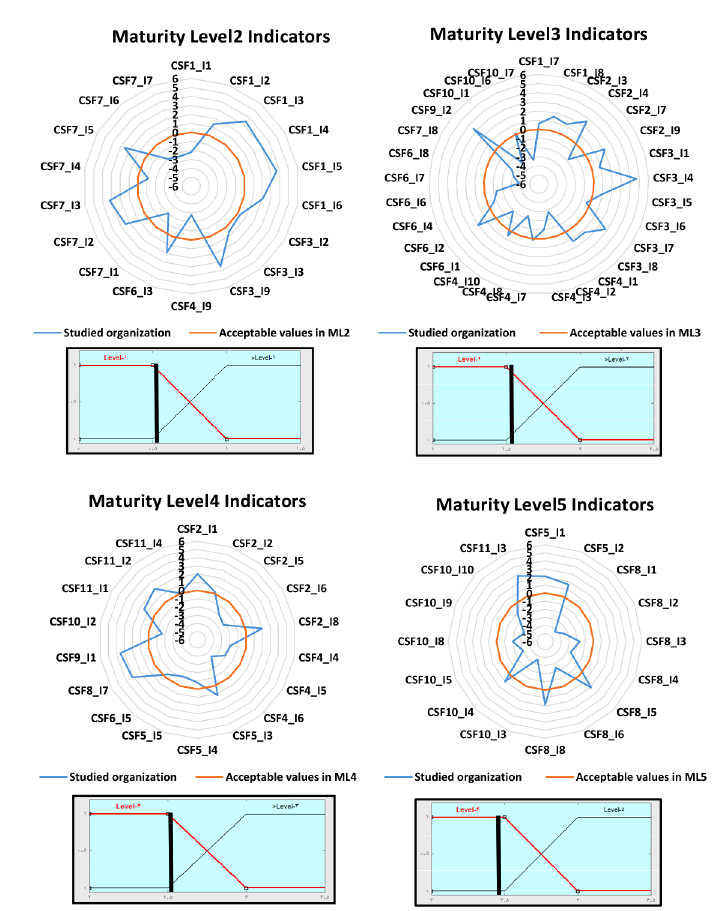
Figure 4. Radar graph, ES1 (the second level (repeatable)), ES2 (the third level (defined)), ES3 (the fourth level (managed)) and ES4 (the fifth level (optimized)) outputs